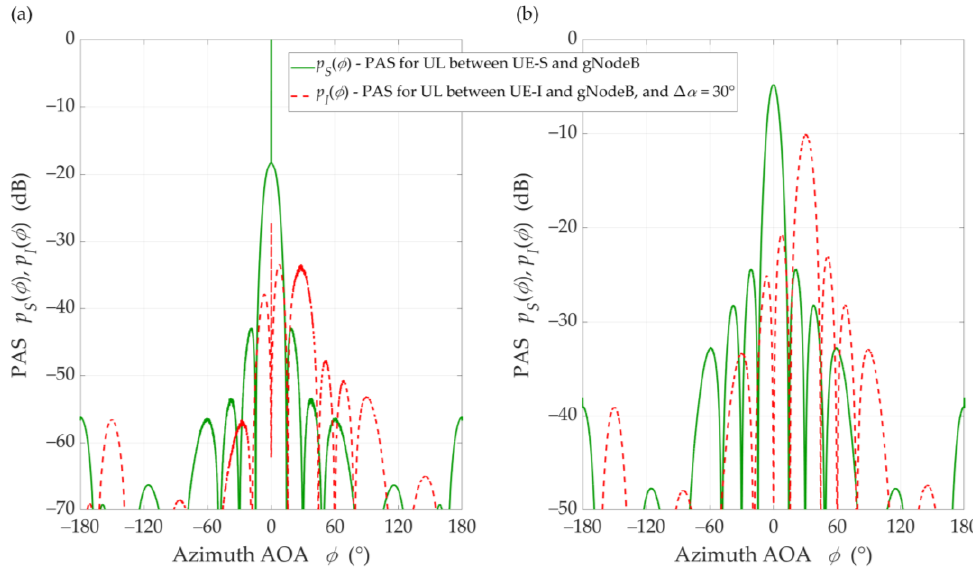
Figure 5. PASs of UE-S and UE-I in azimuth plane for ∆ α = 30°, D S = D I = 100 m, under ( a ) LOS (TDL-D) and ( b ) NLOS (TDL-B) conditions.